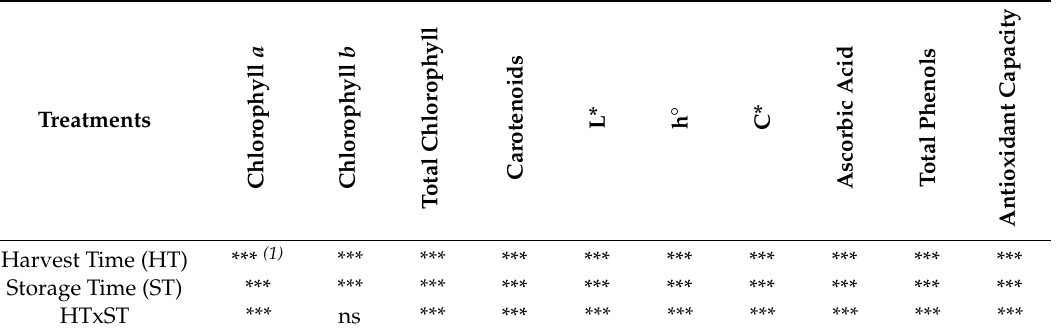
Table 3. E ff ect of growing cycle and cold storage time on the color and anti-oxidative traits of broccoli (cv.